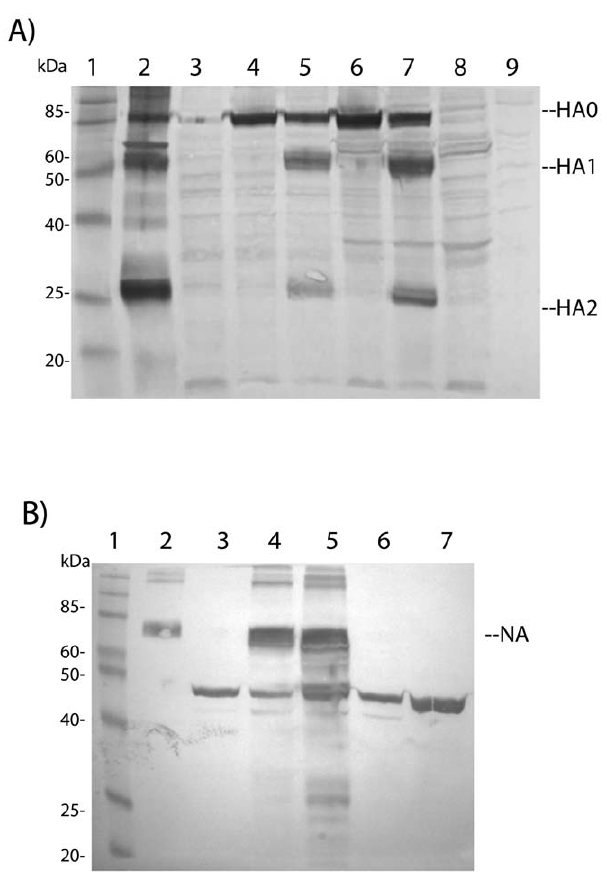
Figure 1. Western blots of chicken cell (DF-1) lysates probed for influenza antigens. (A) Hemagglutinin expression in chicken cells. Lane 1, marker size in kDa. Lane 2, formalin-inactivated purified H1N1 influenza virus. Lane 3, negative control, DF-1 cells infected with wt vaccinia virus. Lane 4, replicating virus rVVL-H1-Ca, no trypsin treatment. Lane 5, replicating virus rVVL-H1-CA, with trypsin treatment. Lane 6, MVA-H1-Ca, no trypsin treatment. Lane 7, MVA-H1-Ca, with trypsin treatment. Lane 8, negative control lysate, MVA wt virus. Lane 9, uninfected cell lysate. HA0, unprocessed hemagglutinin; HA1 and HA2, the two processed HA subunits. B) Neuraminidase expression in chicken cells. Lanes 1-3, samples as above. Lane 4, replicating virus rVVL-N1-Ca. Lane 5, MVA-N1-Ca. Lane 6 and 7, negative controls, lysates of MVA wt virus and non-infected DF-1 cells. The band around 75 kDa represents the neuraminidase